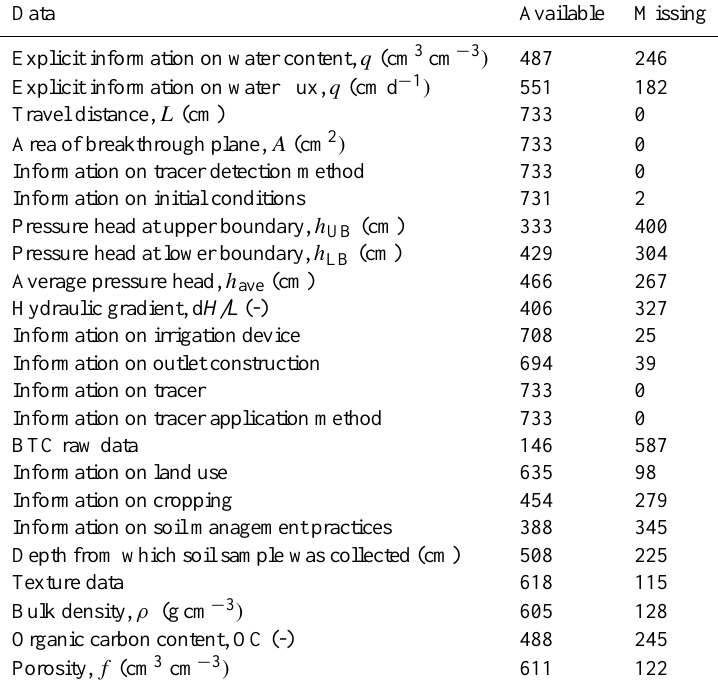
Table 2. Inventory of the data available in the database.